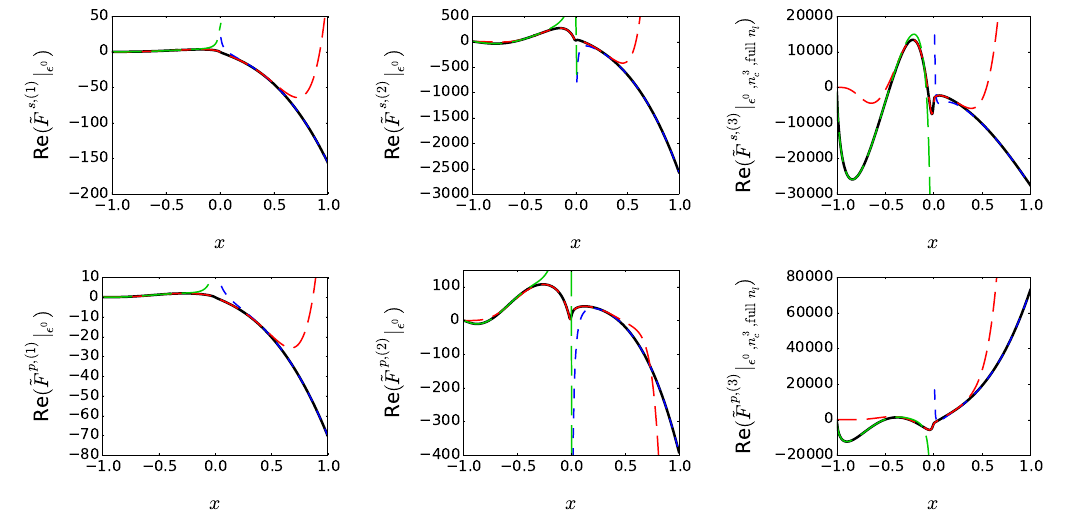
Figure 4 . Same as figure 3 but for the scalar and pseudo-scalar